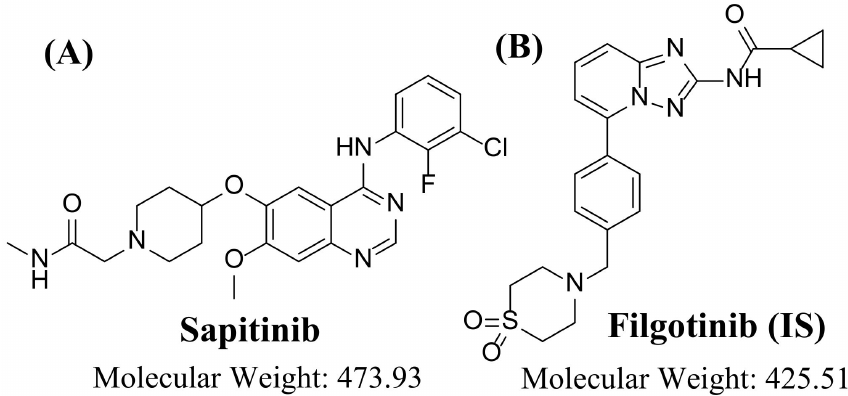
Figure 1. Chemical structures of ( A ) sapitinib and ( B ) filgotinib (internal standard;